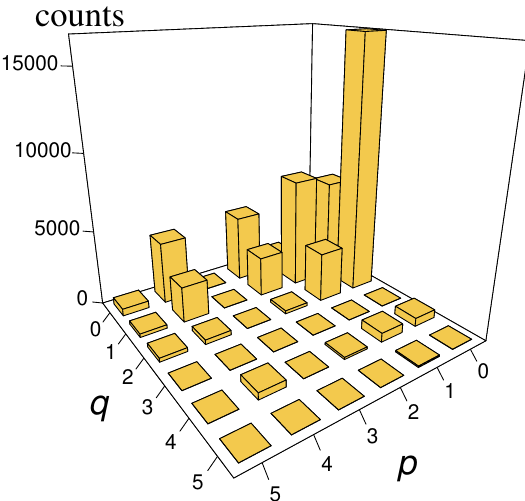
Figure 4. Joint histogram of the model parameters p and q obtained from an analysis of n s = 5.5 × 10 4 training series { u ( t (cid:48) + t ) } 1 ≤ t ≤ N , t (cid:48) = 1, . . . , n s of length N s = 3 × 10 3 s